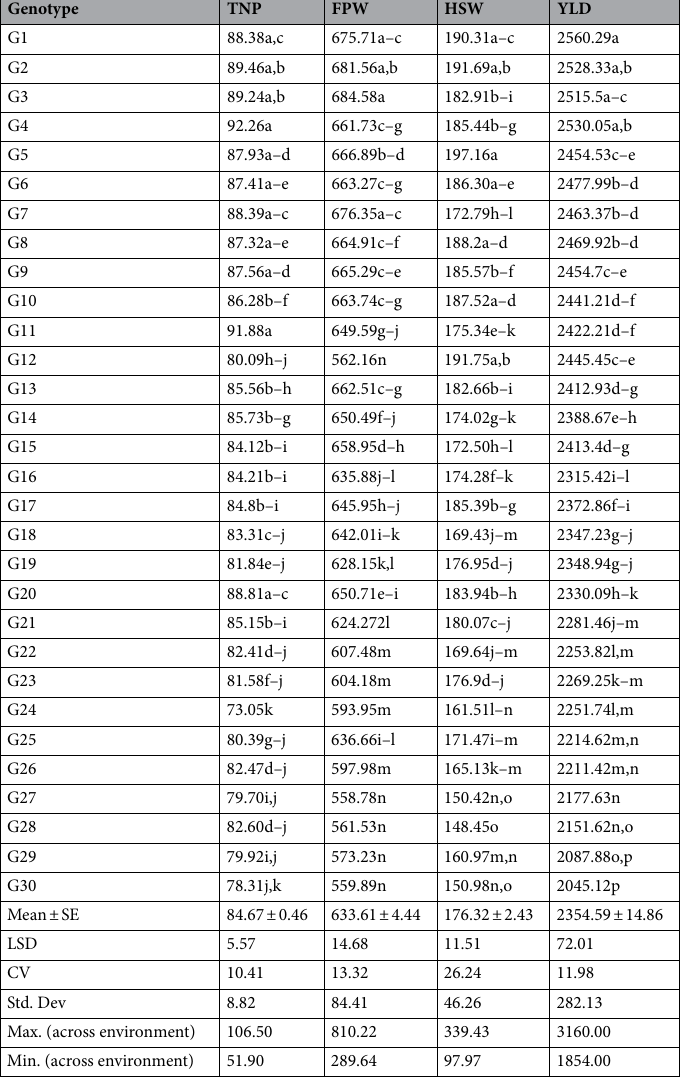
Table 5. Mean performance and their comparisons of V. subterranean genotypes for yield and yield contributing traits over four environments (two seasons at two locations). TNP total number of pods, FPW fresh pod weight (g), HSW hundred seed weight (g), YLD yield (kg/ha), CV coefficient of variation, Se . standard error, Std. Dev. standard deviation, Max. maximum, Min. minimum. Means within each column with the same letter are not significantly different with LSD test at p >